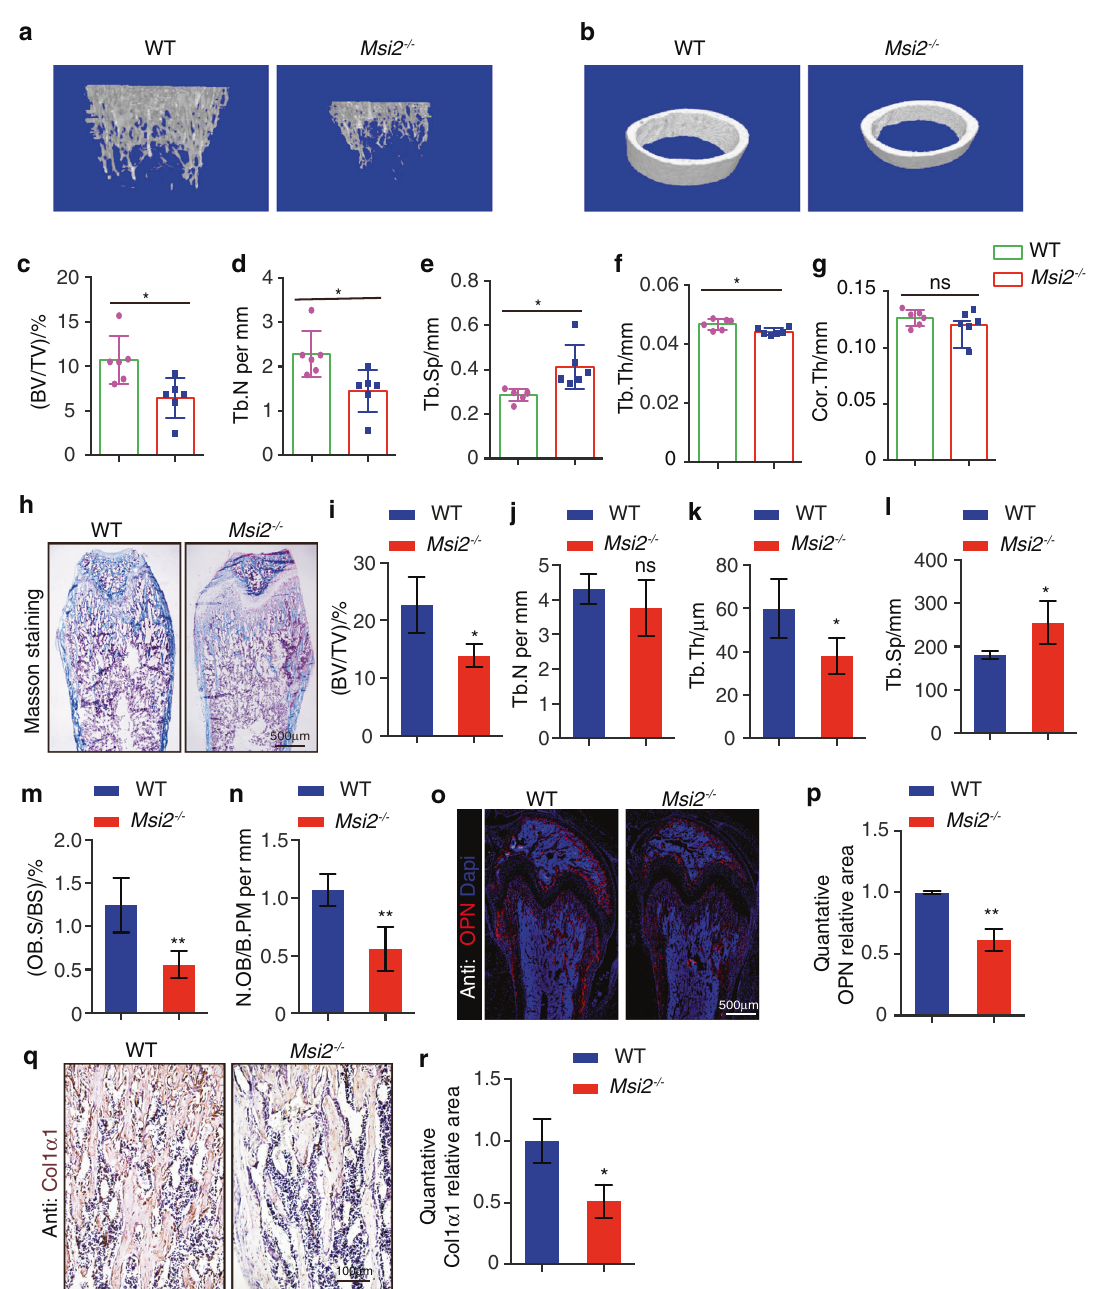
Fig. 3 Msi2 -de fi cient mice show decreased bone mass. a Three-dimensional μ -CT images of trabecular bone of distal femurs isolated from the 6-week-old female WT and Msi2 − / − mice ( n = 6). b Three-dimensional μ -CT images of cortical bone of distal femurs isolated from the 6-week-old female WT and Msi2 − / − mice ( n = 6). c – g μ -CT analysis of distal femurs from the 6-week-old WT and Msi2 − / − mice for trabecular bone volume per tissue volume (BV/TV) ( c ), trabecular number (Tb.N) ( d ), trabecular separation (Tb.Sp) ( e ), trabecular thickness (Tb.Th) ( f